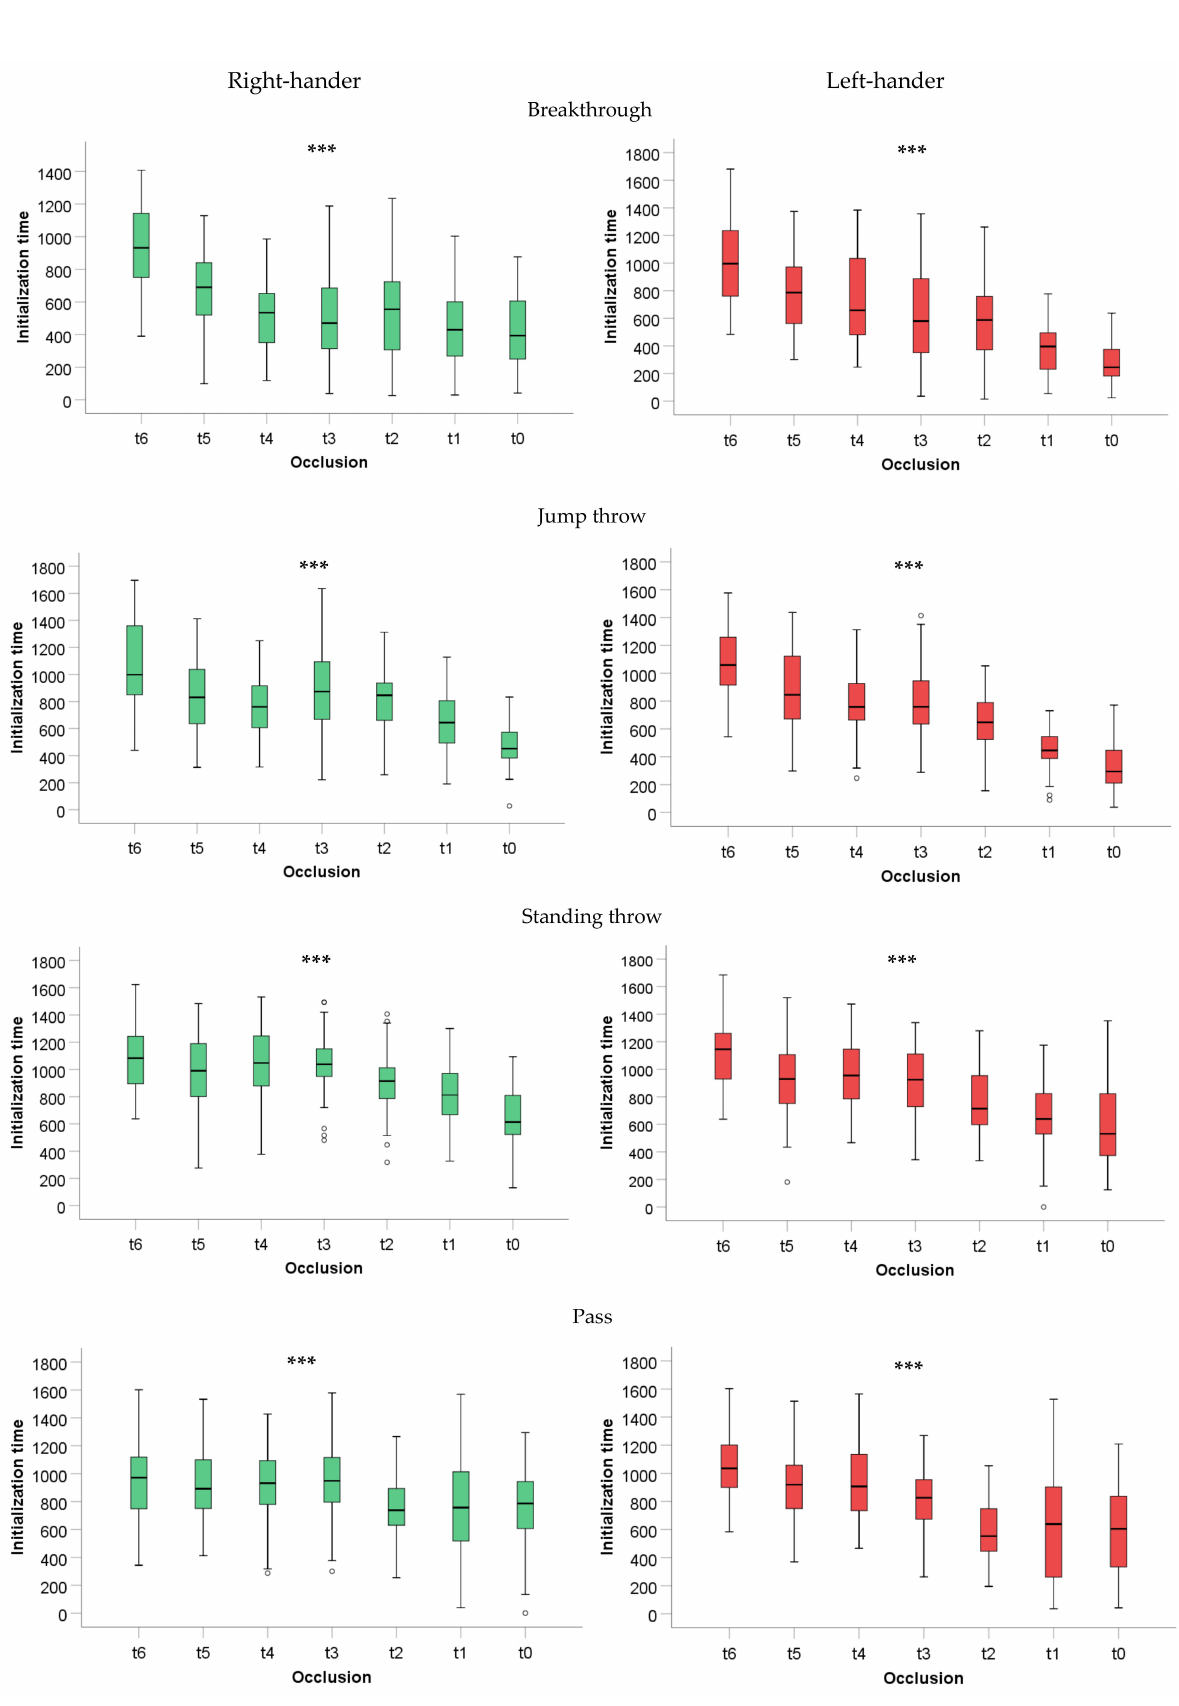
Figure 7. Intra-session initialization times (mean of video pairs in ms) of motor responses for all attacks (*** p <